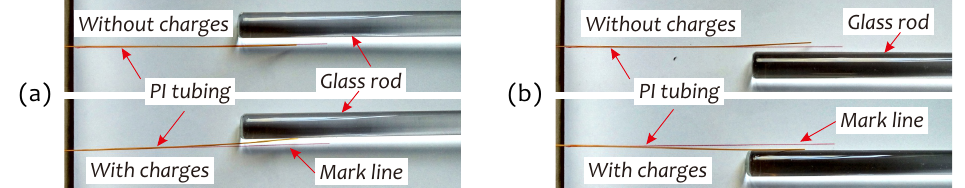
Figure 7. Four photographs for verifying charge polar in PI tubing. A positively charged glass rod was placed on left side ( a ) or right side ( b ) of PI tubing with or without charges. Mark line is to indicate original position of PI